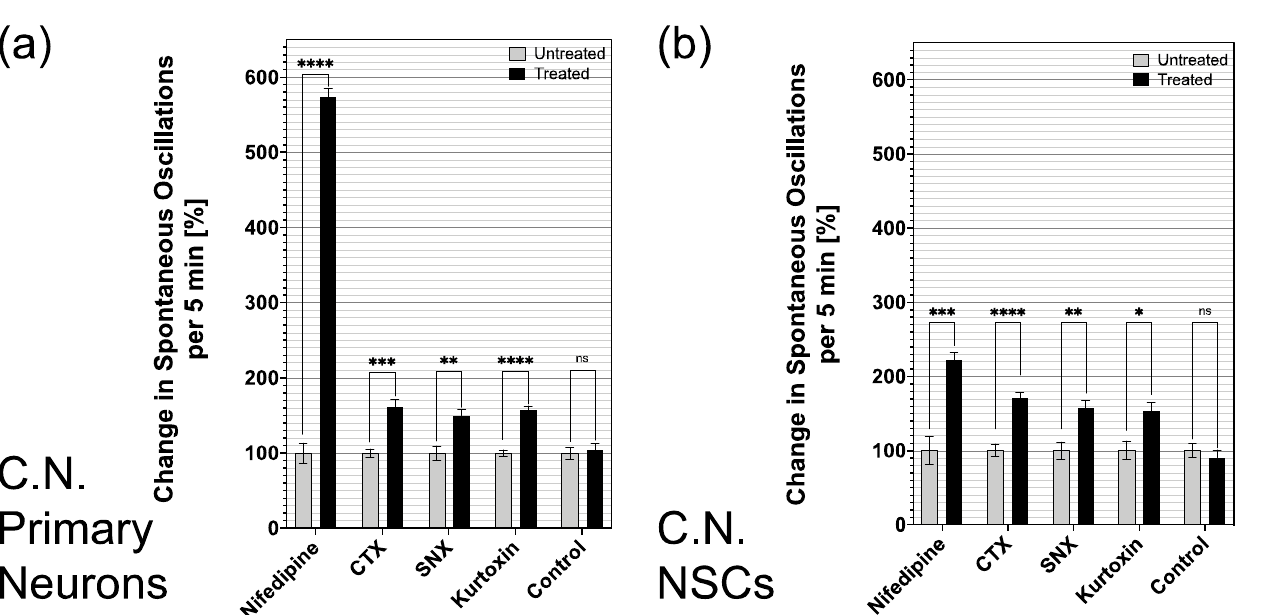
Figure 4. Calcium Imaging Analysis of CN NSC spontaneous oscillations with the application of specific calcium channel modulators: ( a ) control solution (HBSS), ( b ) nifedipine, ( c ) ω -Conotoxin (CTX), ( e ) SNX-482, and ( f ) kurtoxin. The red vertical bar indicates the time of application of the corresponding substances. Blue arrows mark the optically controlled calcium maxima of the spontaneous oscillations. The specific fluorescence intensities over 200 s are shown as dimension- less values. ( d ) representative photomicrograph of CN NSC CaI (Calcium Indicator: Oregon Green BAPTA-1) with tagging of different ROIs.